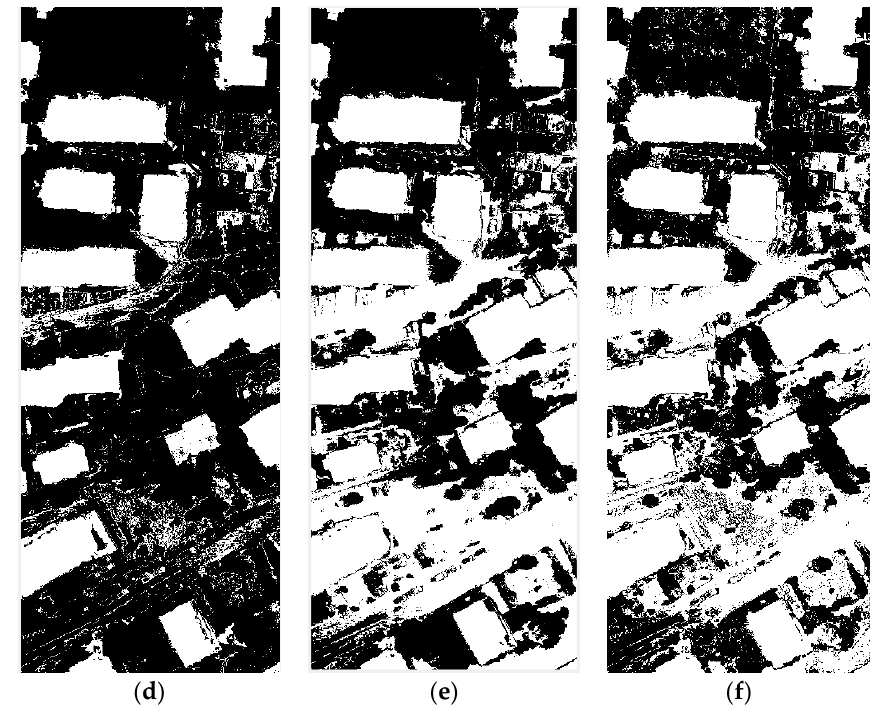
Figure 6. Different proportions of extraction results: ( a ) the ratio of buildings to non-buildings is 2 to 8; ( b ) the ratio of buildings to non-buildings is 3 to 7; ( c ) the ratio of buildings to non-buildings is 4 to 6; ( d ) the ratio of buildings to non-buildings is 5 to 5; ( e ) the ratio of buildings to non-buildings is 6 to 4; and ( f ) the ratio of buildings to non-buildings is 7 to 3. Table 1. Different proportions of extraction results.